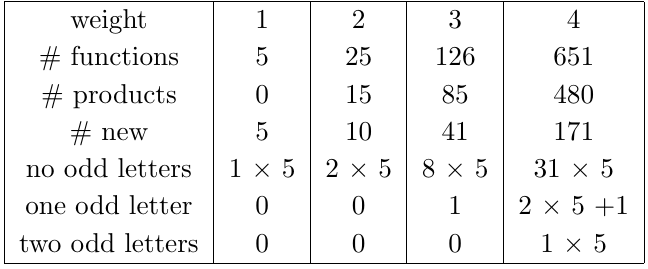
Table 3 . Classi(cid:12)cation of pentagon functions up to weight